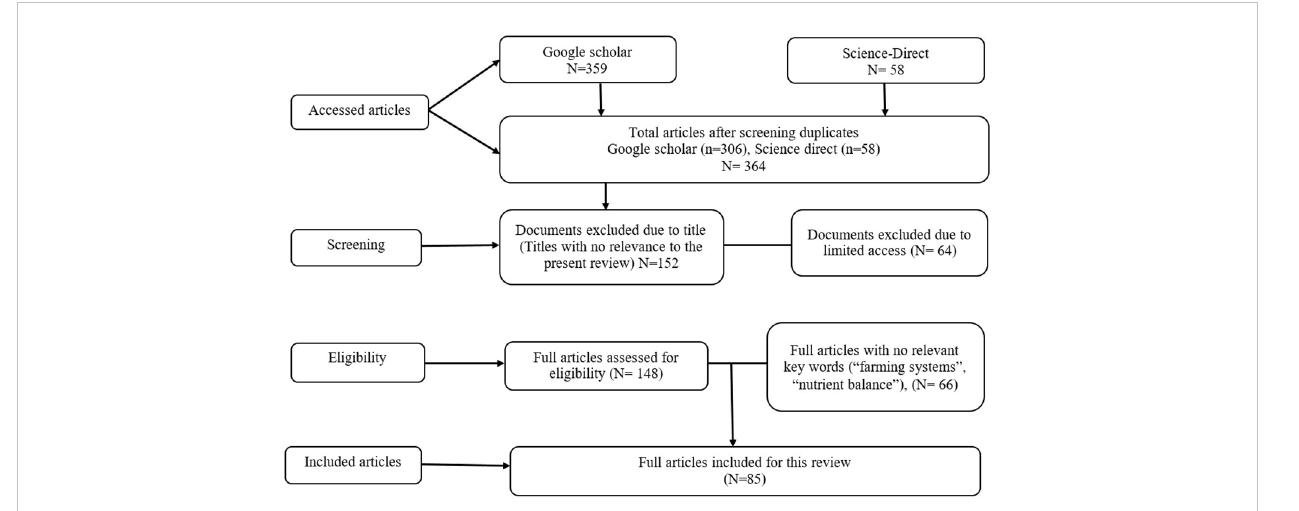
FIGURE 2 A schematic literature search based on PRISMA in acquisition of appropriate articles for this